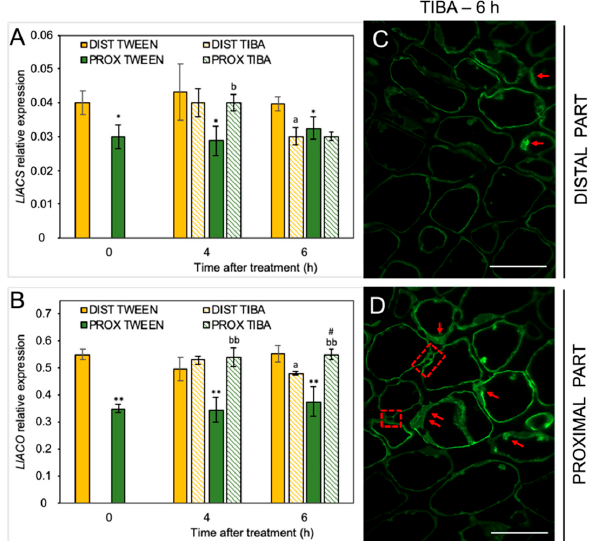
Figure 5. The disruption of polar auxin transport affected the ethylene (ET) biosynthesis pathway in different areas of the AZ. The relative level of 1-aminocyclopropane-1-carboxylic acid synthase ( LlACS ) transcripts ( A ) and 1-aminocyclopropane-1-carboxylic acid oxidase ( LlACO ) ( B ) genes were investigated using qPCR analysis. A solution of 2,3,5-triiodobenzoic acid (TIBA, 0.05 mM in 0.05% Tween 20) or 0.05% Tween 20 was applied directly on the inactive flower abscission zone (AZ). Then, the tissue fragments containing the AZ ( ≈ 1 mm below and ≈ 1 mm above) were dissected 4 h or 6 h after treatments and divided into a proximal (PROX) and a distal (DIST) part for further RNA isolation. LlACT ( ACTIN ) was used as an internal control for the normalization of gene expression. The average values and SD of three measurements per treatment are shown. t -test: ** p < 0.01 and * p < 0.05, proximal versus distal part in Tween 20-treated AZ for different times after application, a p < 0.05, TIBA-treated distal part versus Tween 20-treated distal part; bb p < 0.01 and b p < 0.05, TIBA-treated proximal part versus Tween 20-treated proximal part for different times after application, # p < 0.05, proximal versus distal part in the TIBA-treated AZ. The localization of the ET precursor 1-aminocyclopropane-1-carboxylic acid (ACC) in the distal ( C ) and proximal ( D ) areas of the flower AZ 6 h after the TIBA application. The green fluorescence signal indicates ACC localization (red arrowheads). Red squares indicate the presence of ACC in the possibly formed plasmodesmata. Scale bars: 40 µM.